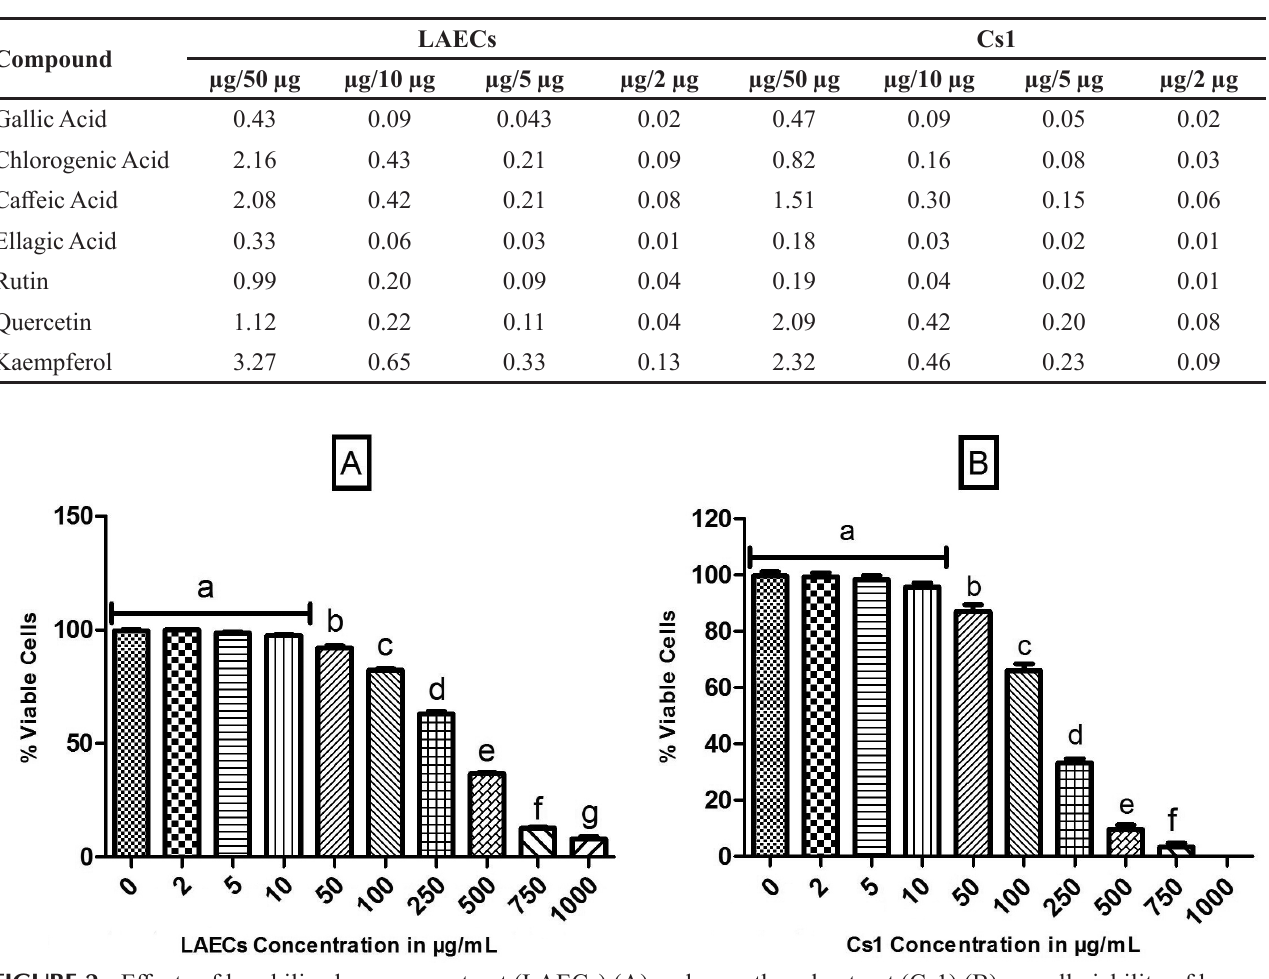
FIGURE 2 - Effects of lyophilized aqueous extract (LAECs) (A) and raw ethanol extract (Cs1) (B) on cell viability of human leukocytes. 0 µg/mL – Negative control ( phosphate buffered saline). Data are expressed as mean ± SD. Columns with different letters are significantly different